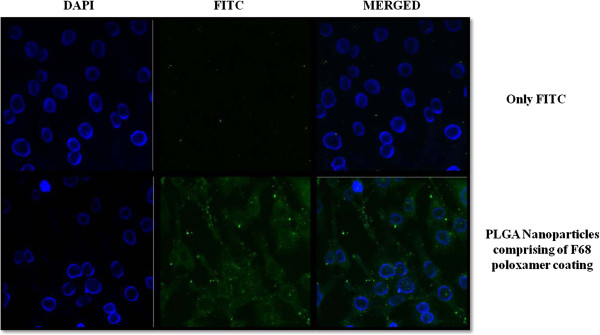
Immunofluorescence studies for cellular uptake of developed nanoparticles. Cells treated with FITC showed almost negligible fluorescence indicating absence of its uptake. However, cells treated with FITC loaded nanoparticles exhibited strong green fluorescence. Nucleus is stained with DAPI represented in dark blue colour.